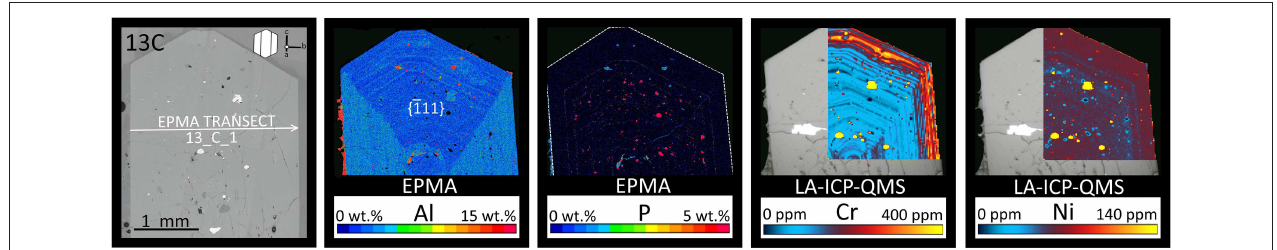
FIGURE 4 | Elongated section of crystal 13, cut along the c -axis (section 13C). The section was imaged under reflected light (left panel), and chemically using electron microprobe (Al, P: middle panels) and LA-ICP-QMS (Cr, Ni: right panels). The reflected light image includes a 2D crystal model (top right corner) showing the crystallographic orientation of the section (see also Figure 3 ). Reflected light imaging and micro-chemical mapping provide detailed information on inclusion populations and sector zoning. LA-ICP-QMS maps unveil concentric zonation at the trace element